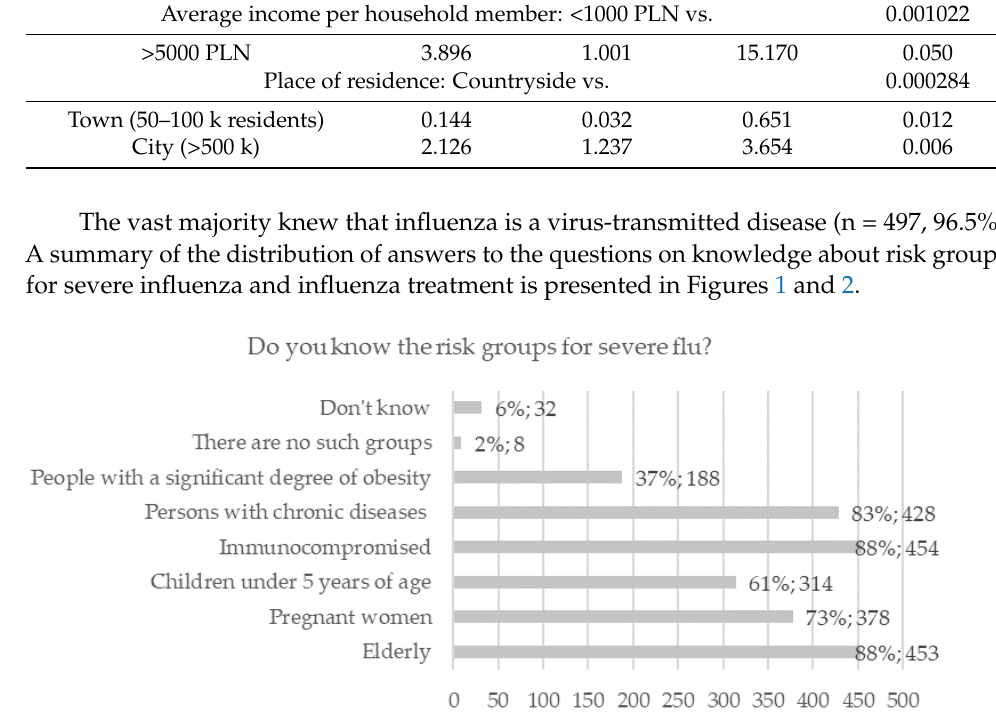
Figure 1. Respondents’ knowledge about risk groups for severe influenza.